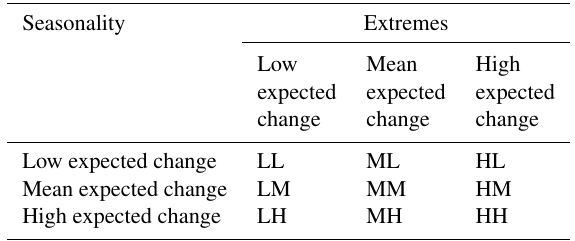
Table 1. Tested combinations of extreme and seasonal changes. Seasonality Extremes Low Mean High expected expected expected change change change Low expected change LL ML HL Mean expected change LM MM HM